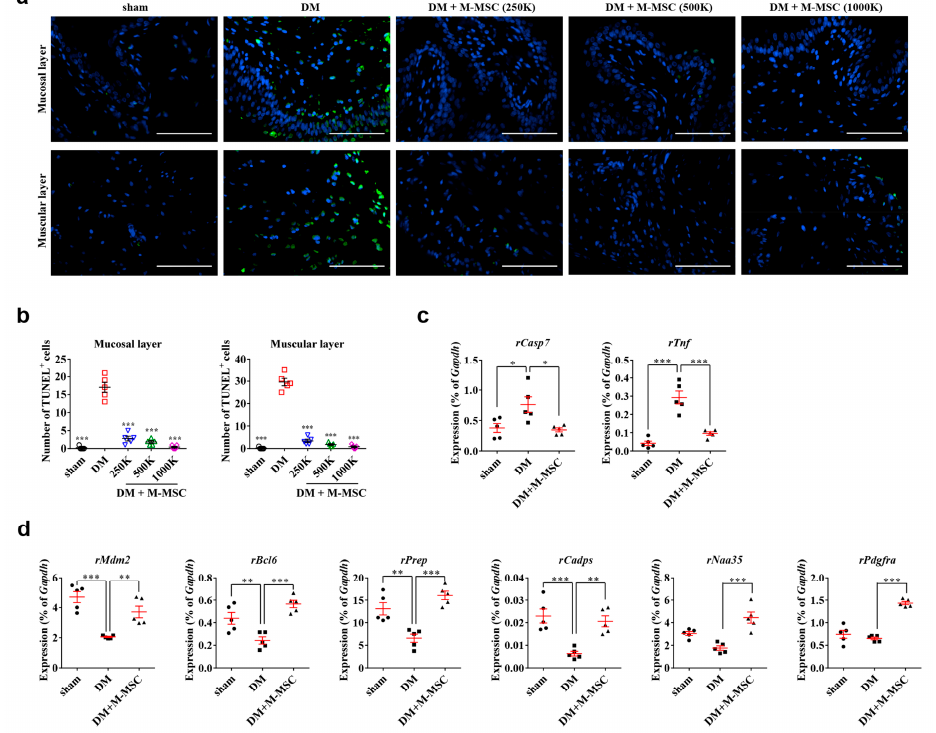
Figure 7. Protective e ff ect of M-MSC therapy against apoptotic cell death in DM bladders. ( a , b ) Representative images (400 × magnification; scale bar, 100 µ m), ( a , b ) quantification of TUNEL + cells in bladder tissues of DM rats at 1 week after injection of M-MSCs or PBS. For quantification, three representative areas per slide were randomly selected from five individual animals per group, relative to DM group, one-way ANOVA with Bonferroni post-hoc comparison). ( c , d ) RQ-PCR analyses of mRNA levels of ( c ) pro-apoptotic and ( d ) anti-apoptotic genes in bladder tissues of DM rats 1